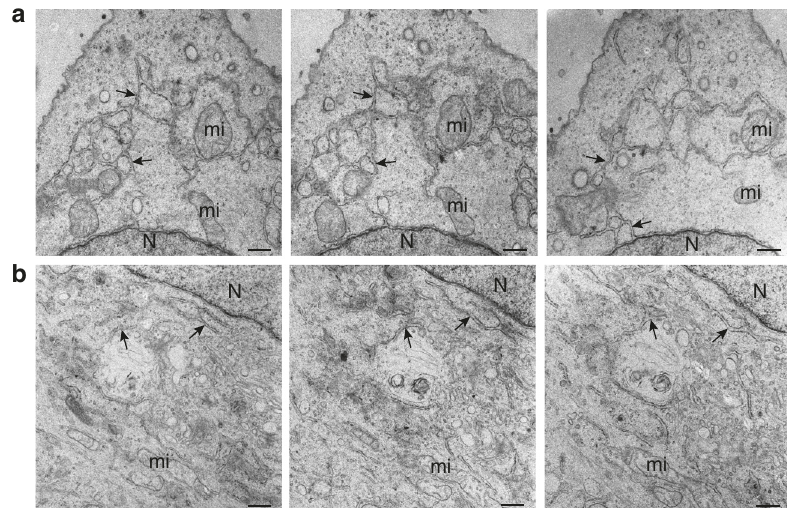
Fig. 2 IAV induces a general remodeling of the ER. a Serial sections of a WSN-infected A549 cell at 8 hpi showing long ER elements (arrows) expanding from the nucleus to the cell periphery. b Serial sections of a mock-infected A549 cell. ER cisternae near the nucleus (N) are marked with arrows; mi, mitochondria. Scale bars, 0.5 μ